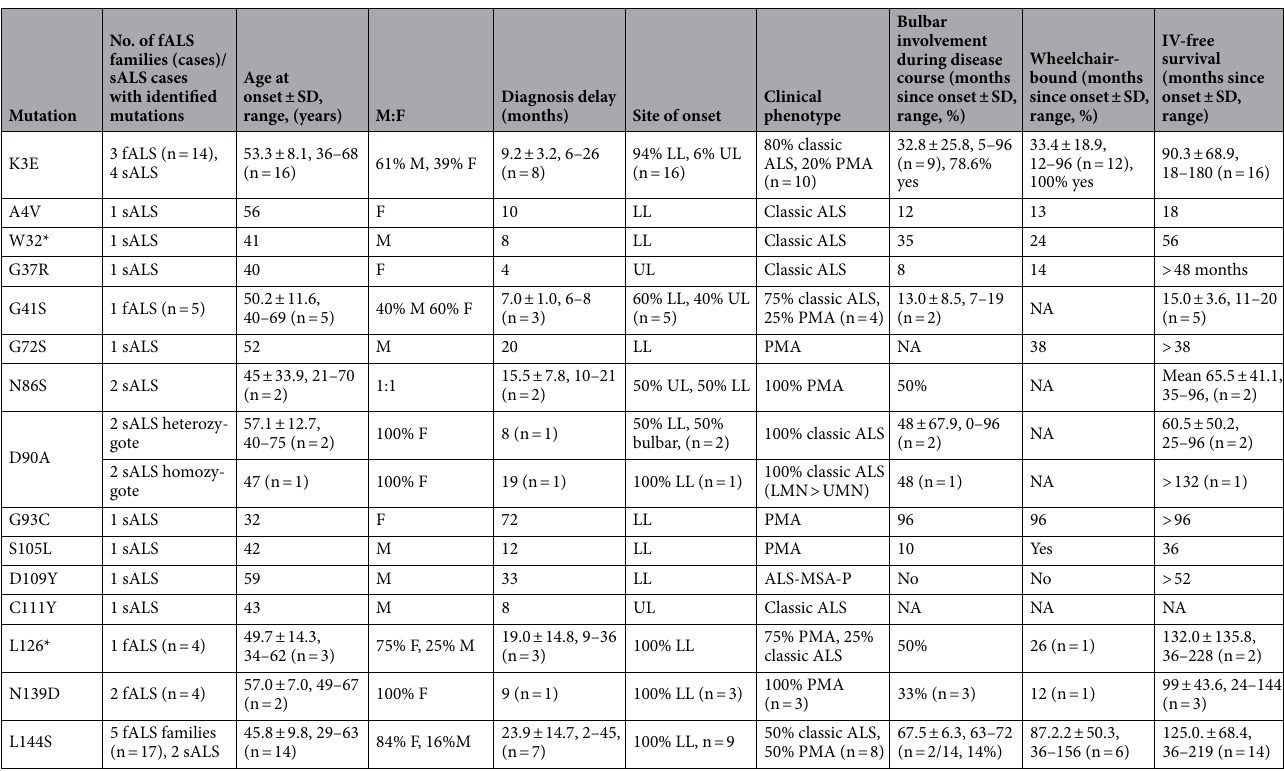
Table 2. Clinical characteristics of ALS patients (n = 52) with SOD1 cds